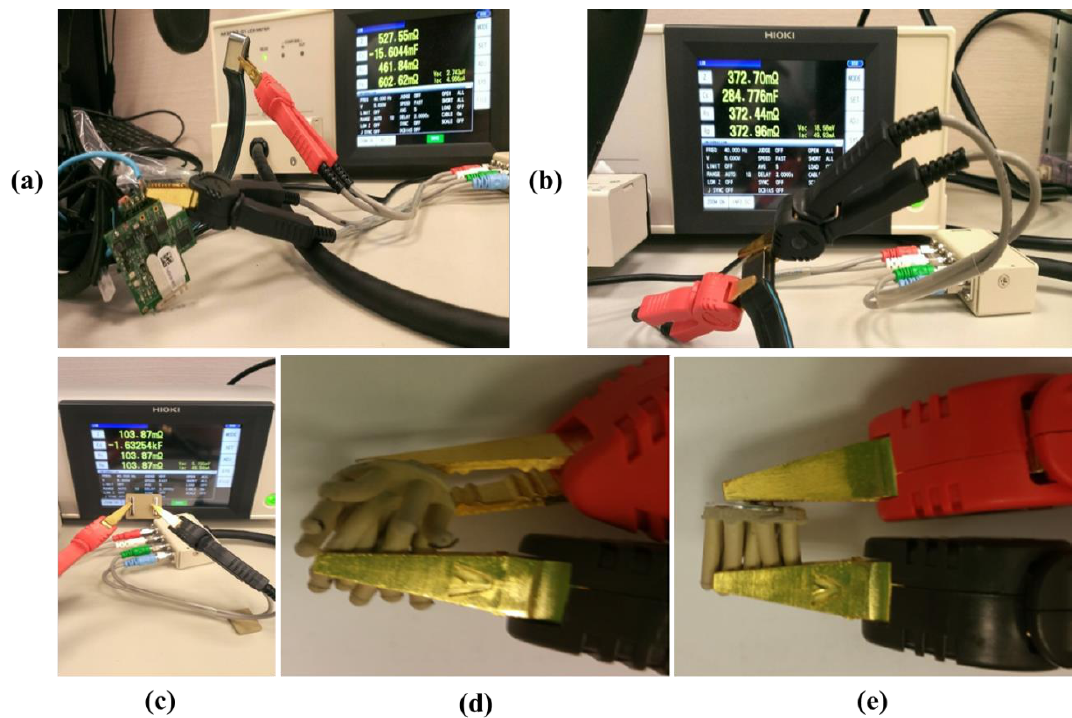
Figure 6. ( a ) and ( b ) Testing of the impedance of flat Neurosky electrodes. ( c ) Flat silicone-based electrode. ( d ) The bent acicular silicone-based dry sensor. ( e ) The impedance of a normal acicular silicone-based dry sensor.